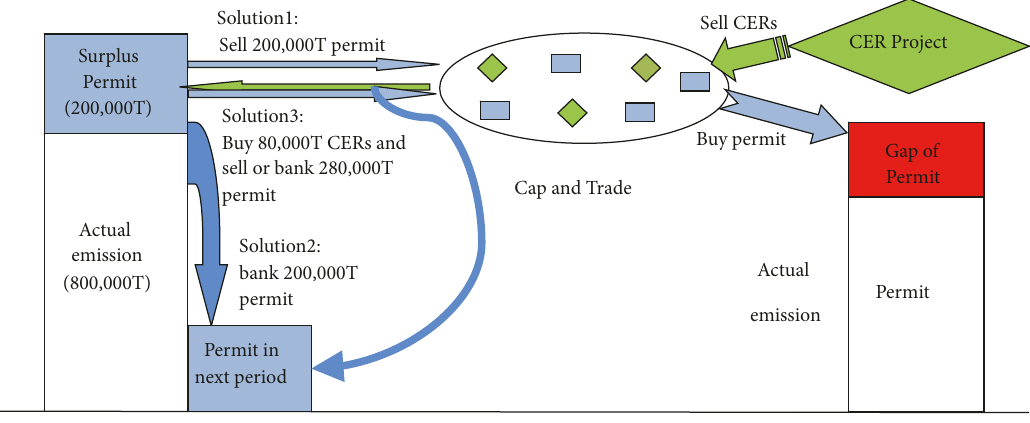
Figure 2: The compliance program of firm